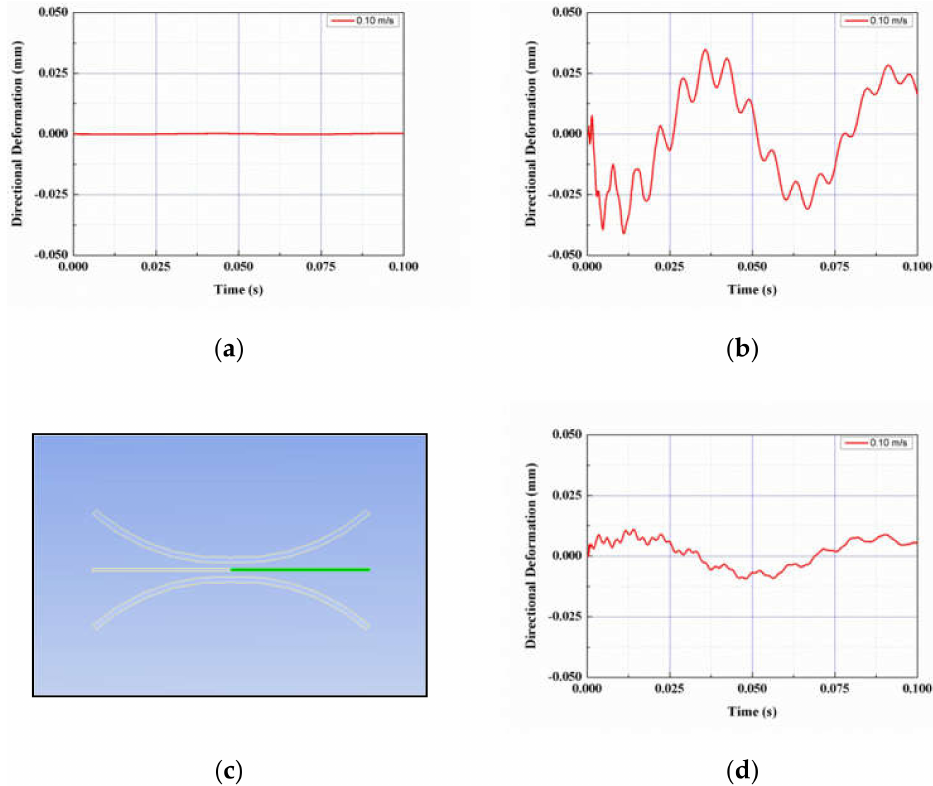
Figure 4. Vibration displacement by numerical simulation: ( a ) without FTEH; ( b ) with FTEH; ( c ) symmetric shape of the FETH; ( d ) vibration displacement of the case ( c